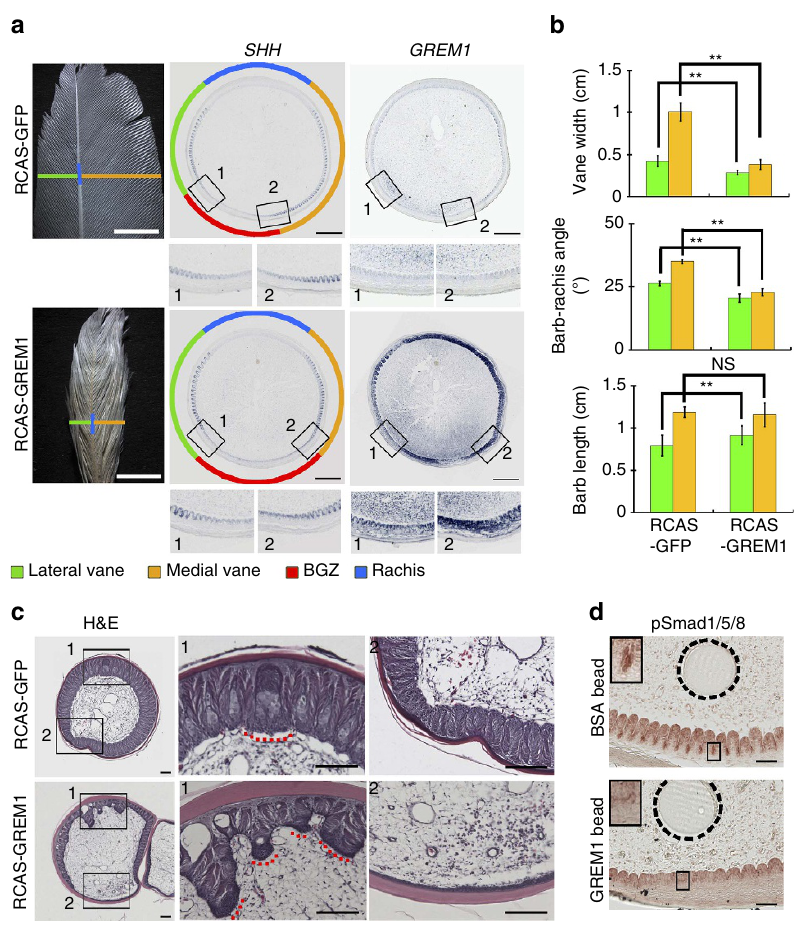
Figure 4 | GREM1 is a key regulator of BGZ topology. ( a ) Compared with the controls, GREM1 mis-expressed adult chicken primary remiges have reduced vane width and increased BGZ width. Boxes indicate the vane boundaries between BGZ and vanes magnified below. Scale bars: 5mm for the leftmost panel, 500 m m for the right two panels. ( b ) Comparing vane widths ( n ¼ 4), barb-rachis angles and barb lengths ( n ¼ 10) in control and GREM1 mis-expressed feathers. Error bars denote s.d. (cid:2)(cid:2) P o 0.01, (cid:2) P o 0.05, NS, not significant. ( c ) RCAS-GREM1 infected neonatal remiges not only had an expanded BGZ but also a branched rachis. Boxed regions are magnified on the right. Dotted red lines highlight the rachis. Scale bar, 100 m m. ( d ) GREM1 soaked beads reduced nuclear pSMAD1/5/8 staining in the neighbouring epithelial cells. Boxed regions are magnified on the top-left corner. Dashed lines highlight the beads. Scale bar, 100 m